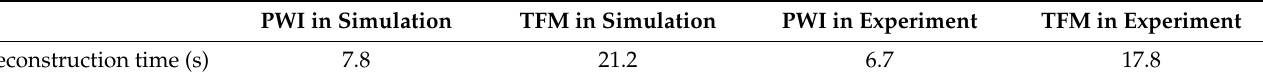
Table 4. Reconstruction time by the TFM and PWI methods.